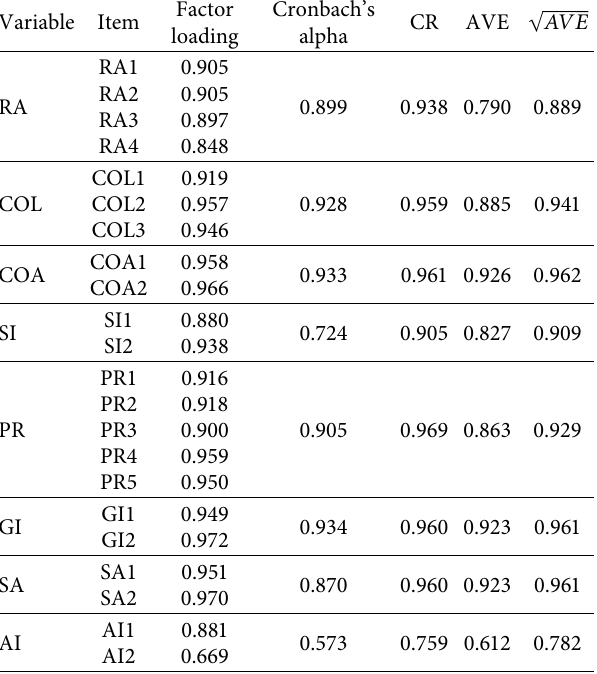
Table 5: Results for factor loading, Cronbach’s alpha, CR, AVE, and Sqrt of AVE.